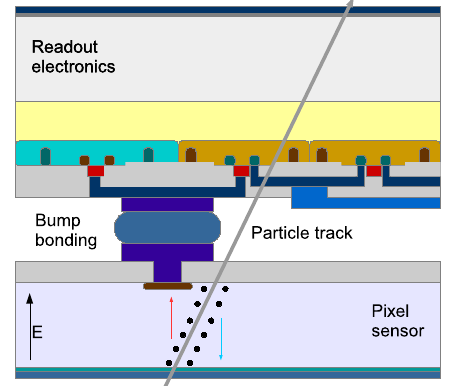
Figure 1. Diagram of a hybrid pixel detector.